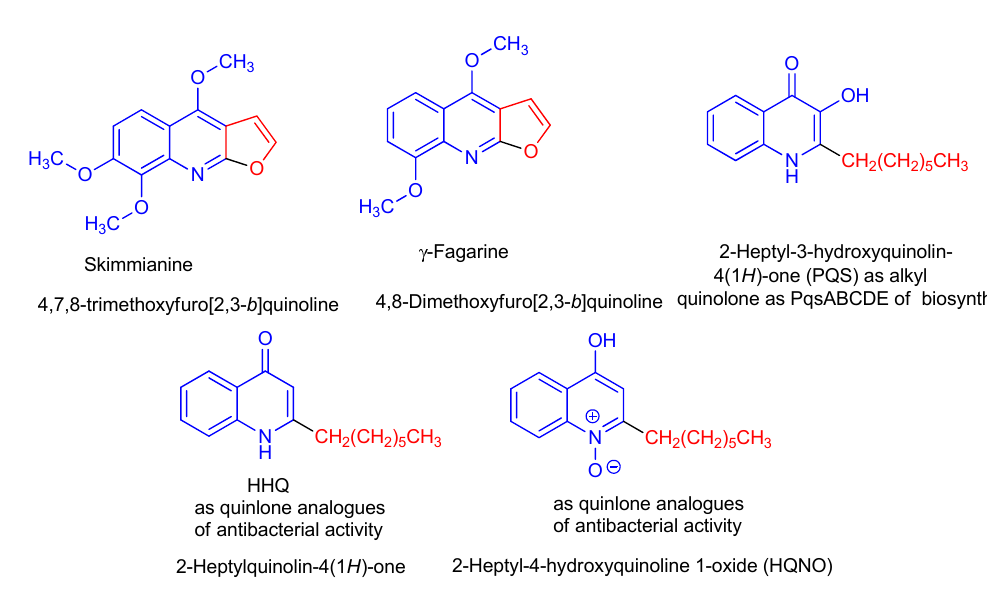
Figure 1. The structures of Skimmianine, γ -Fagarine, an example of QS of PqsABCDE biosynthesis and two examples of quinolone analogues as antibacterial reagents.